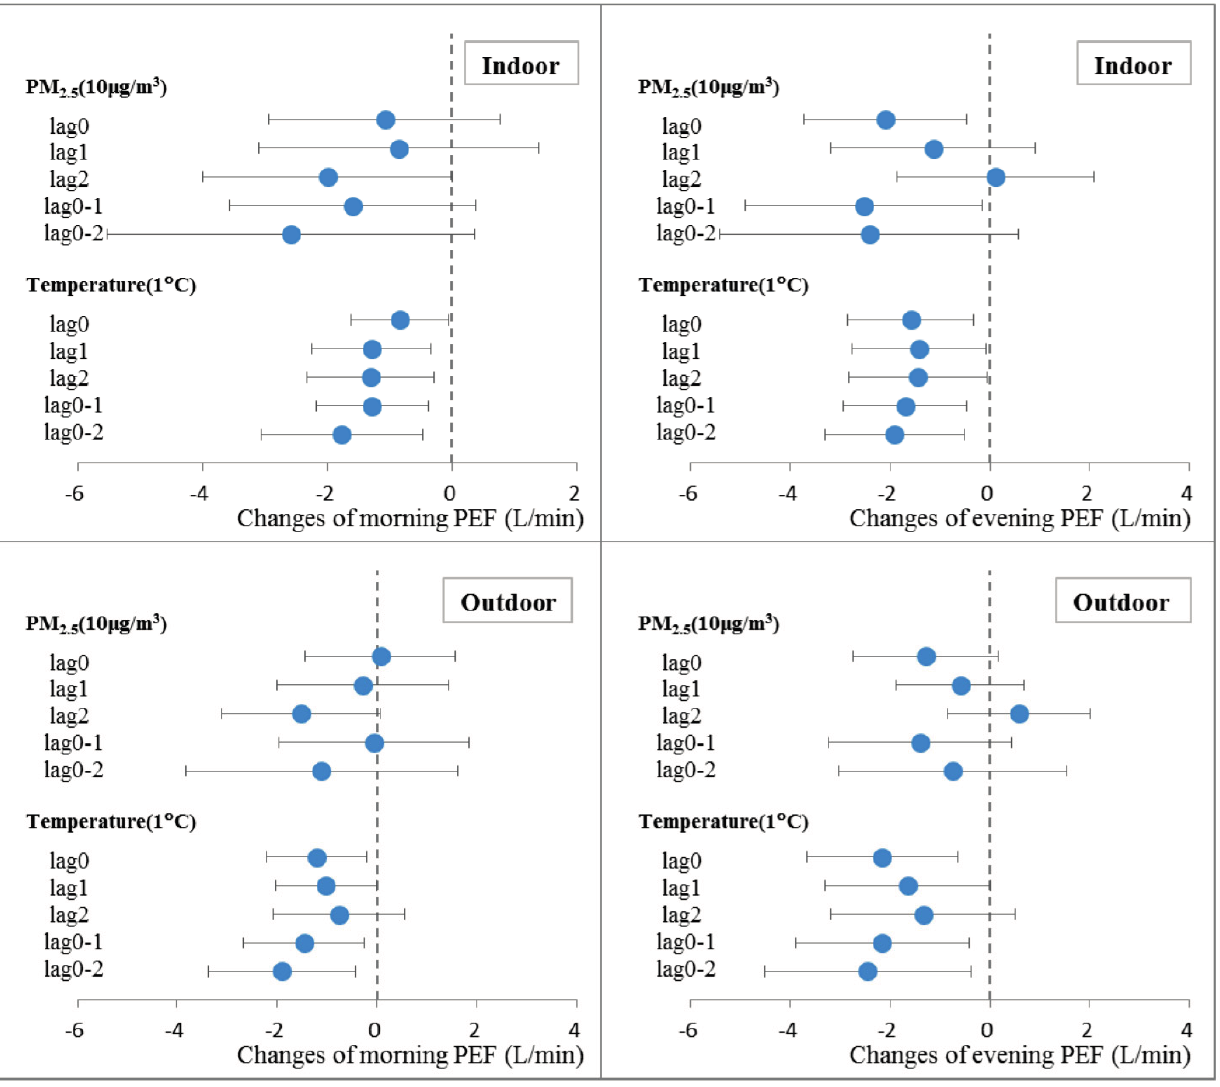
Figure 2. Lagged and cumulative effects of indoor/outdoor PM 2.5 and temperature on morning/evening PEF up to two days in single-pollutant model. Estimates for changes in PEF with 95% confidence intervals were shown per 10 μ g/m 3 increase of PM 2.5 or 1 °C increase of temperature, which were adjusted for season, gender, height, temperature and relative